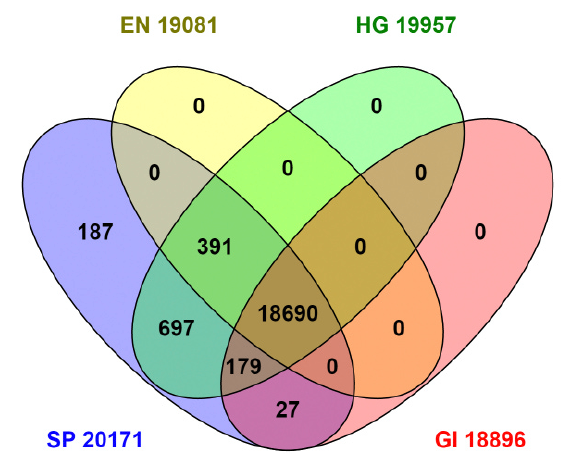
Figure 3. Intersects between identifier cross-references recorded from the UniProt interface. The results are generated via cross-reference totals according to UniProt, not from the sources in situ . EN, Ensembl; SP, Swiss-Prot; HG, Human Gene Nomenclature Committee; GI, NCBI Entrez